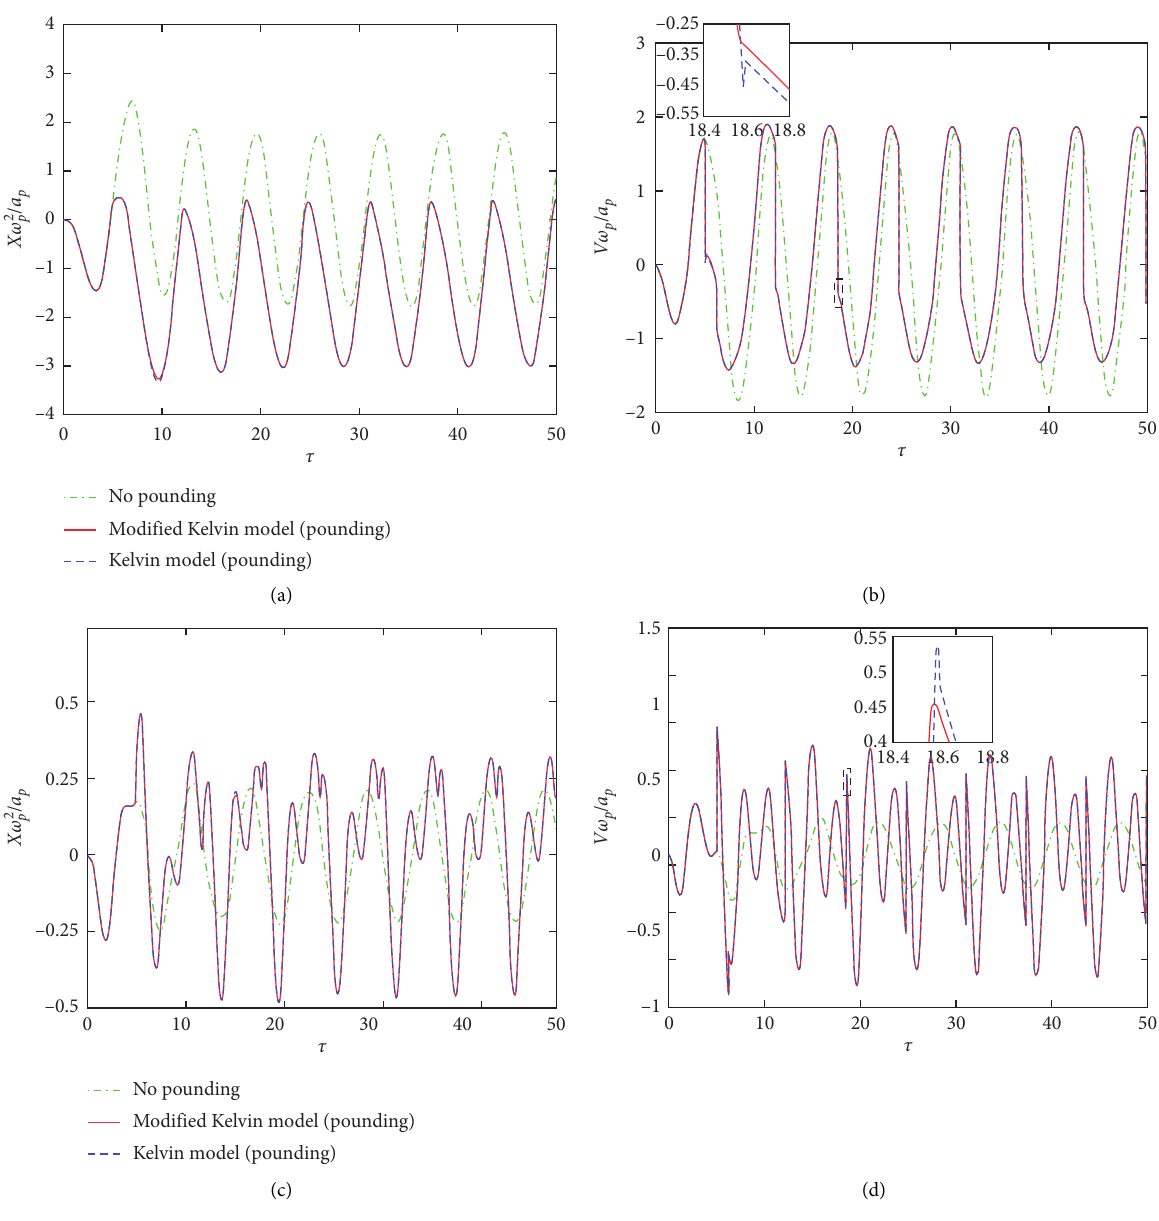
Figure 4: Time-history responses of two inelastic SDOF structures under different impact elements with parameter set 1. (a) Displacement histories of left-side structure. (b) Velocity histories of left-side structure. (c) Displacement histories of right-side structure. (d) Velocity histories of right-side